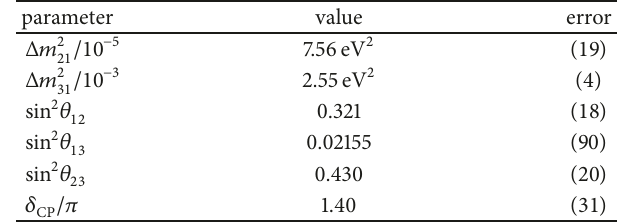
Table 3: Current best fit values of Standard-3 ] as given by [82]. Notice that Normal Hierarchy is